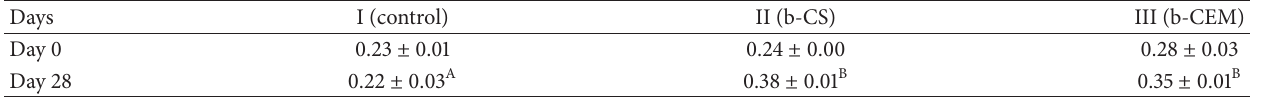
Table 3: Mean ± SE of absorbance at 492 𝜂 m wavelength (OD 492 ) of ELISA reaction on days 0 and